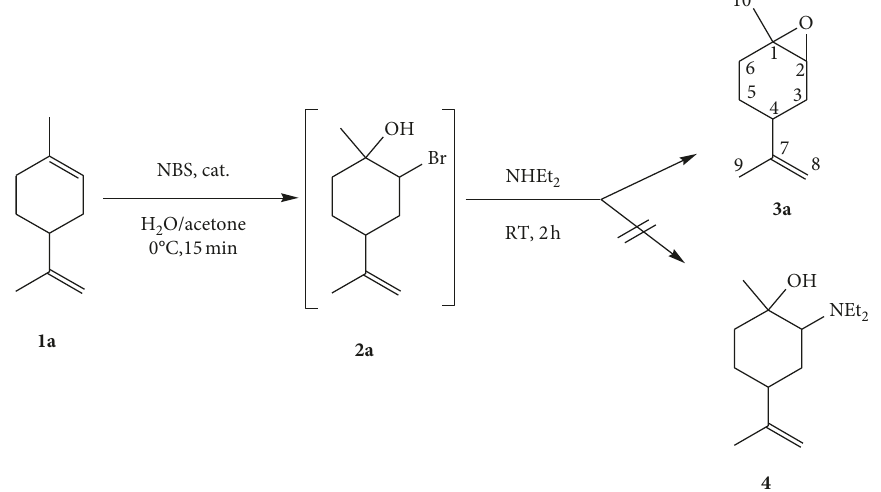
Scheme 2: Synthesis of epoxide 3a via bromohydrin. Table 5: Amine effect on the synthesis of epoxide 3a . Entry Amine